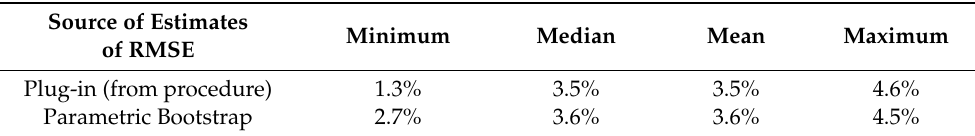
Table 1. Summary statistics for estimated RMSE using output from the GLIMMIX procedure, para- metric bootstrap.